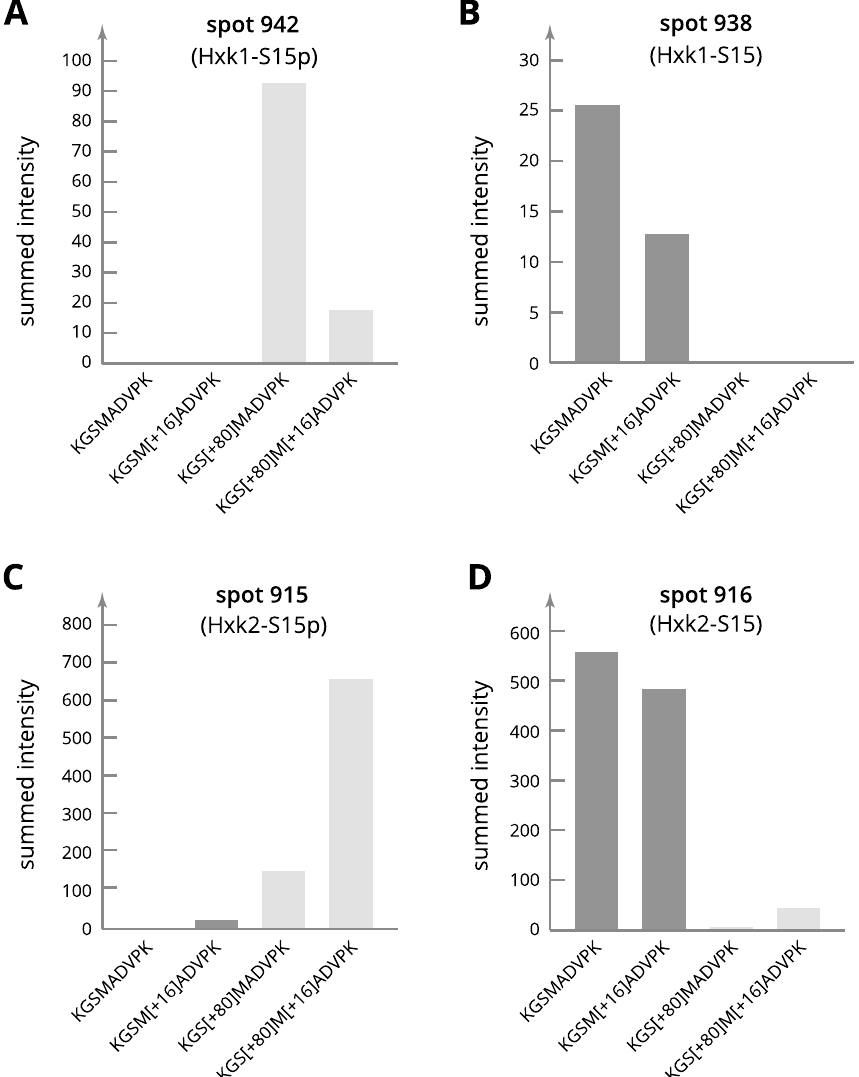
Figure 2. Evaluation of serine 15 phosphorylation in spots with Hxk1 and Hxk2 by PRM. 1 mg of the internal standard, containing aliquots of all proteomes analyzed in the present study, was separated by 2D-gel electrophoresis. For the data shown in ( A ) and ( B ), samples of the Hxk1 main spots (spot 942 and spot 938) were excised from the preparative 2D-gels, digested with trypsin in gel and analyzed by targeted parallel reaction monitoring. For the data shown in ( C ) and ( D ), samples were taken from the Hxk2 main spots (spot 915 and spot 916). The diagrams each show the search for four specific forms of the peptide K 13 GSMADVPK 21 to evaluate the serine 15 phosphorylation state of the respective protein in each